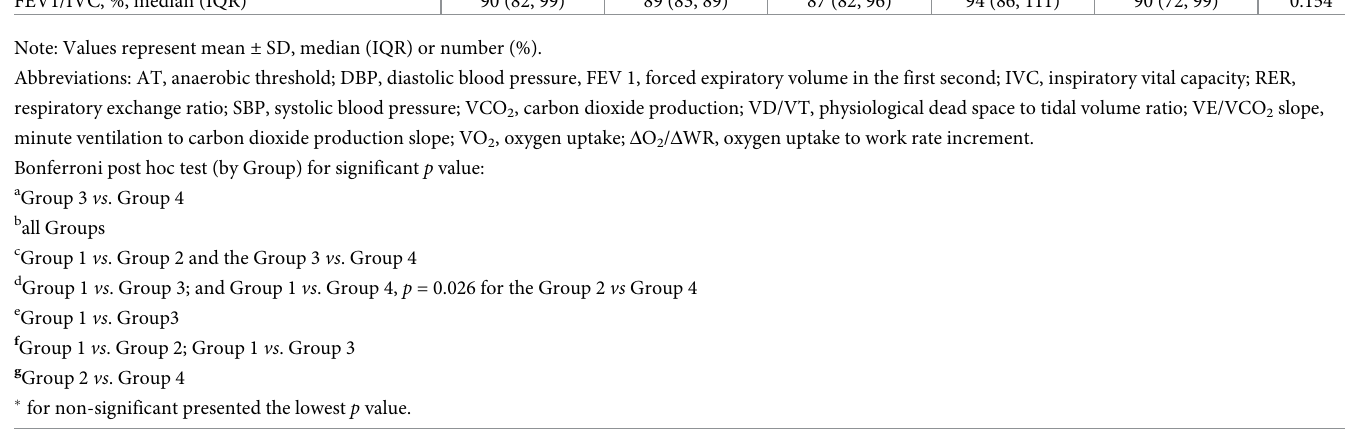
Chronotropic index,